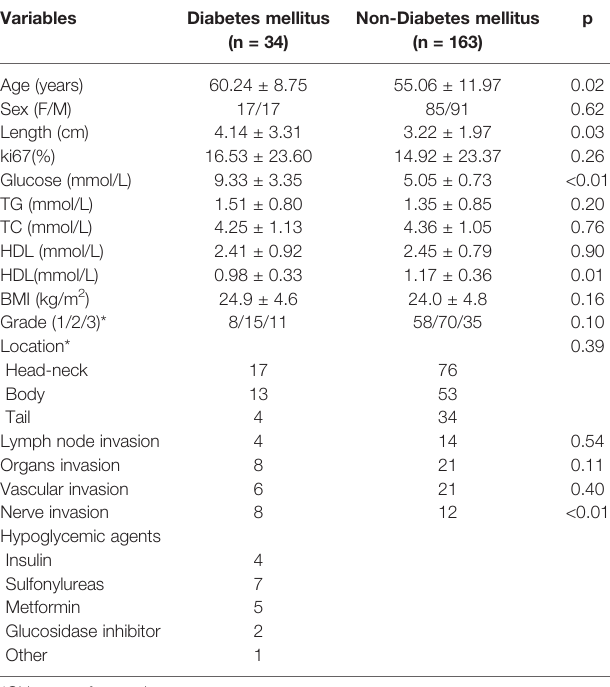
*Chi-square for trend TC, Serum total cholesterol; TG, serum triglyceride; HDL, high-density lipoprotein; LDL, low-density